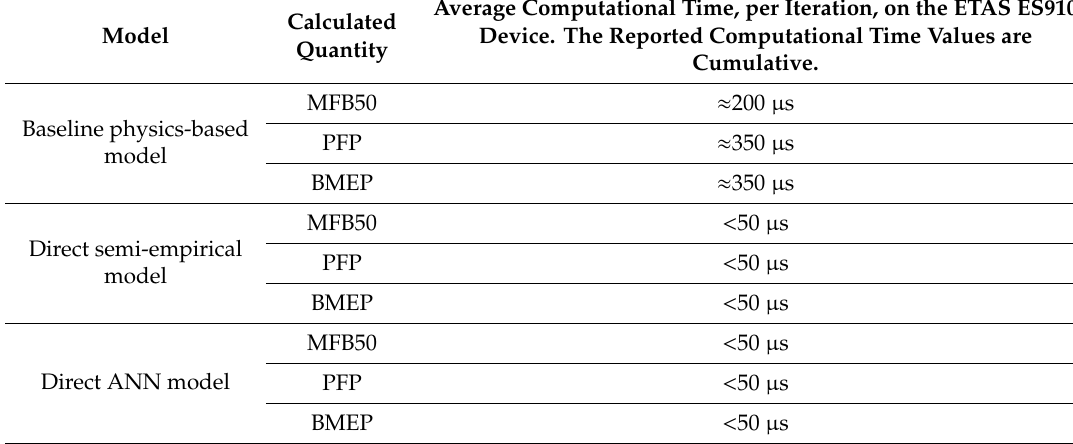
Table 10. Comparison of the computational time for the di ff erent models. Average Computational Time, per Iteration, on the ETAS ES910 Calculated Model Device. The Reported Computational Time Values are Quantity